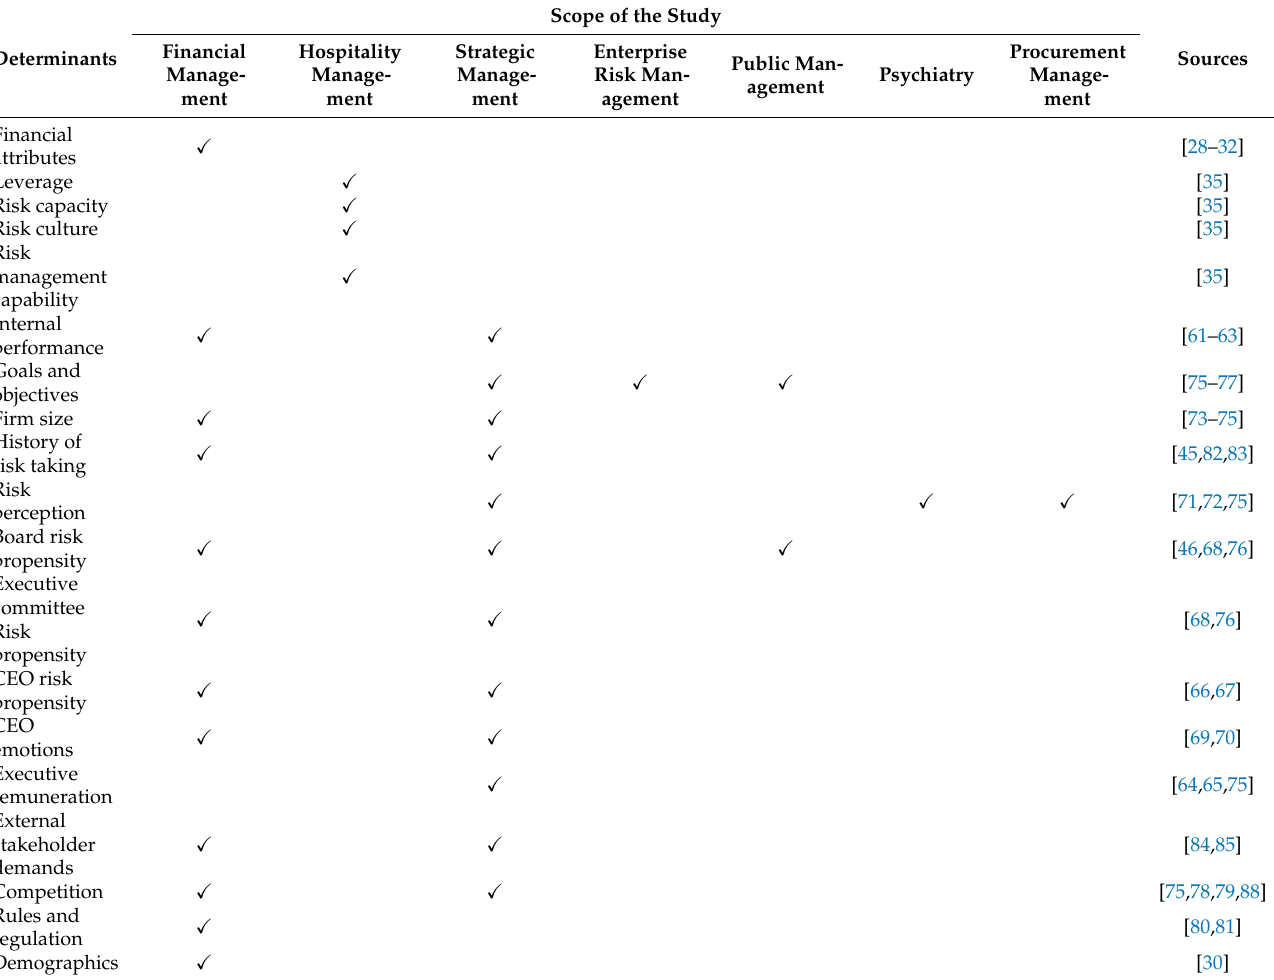
Table 1. Factors which can affect risk